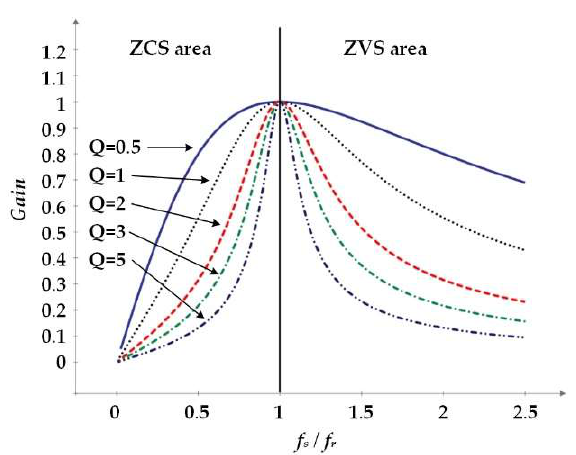
Figure 13. Transfer function curves of RLC series resonant converters under different quality fac- tors.